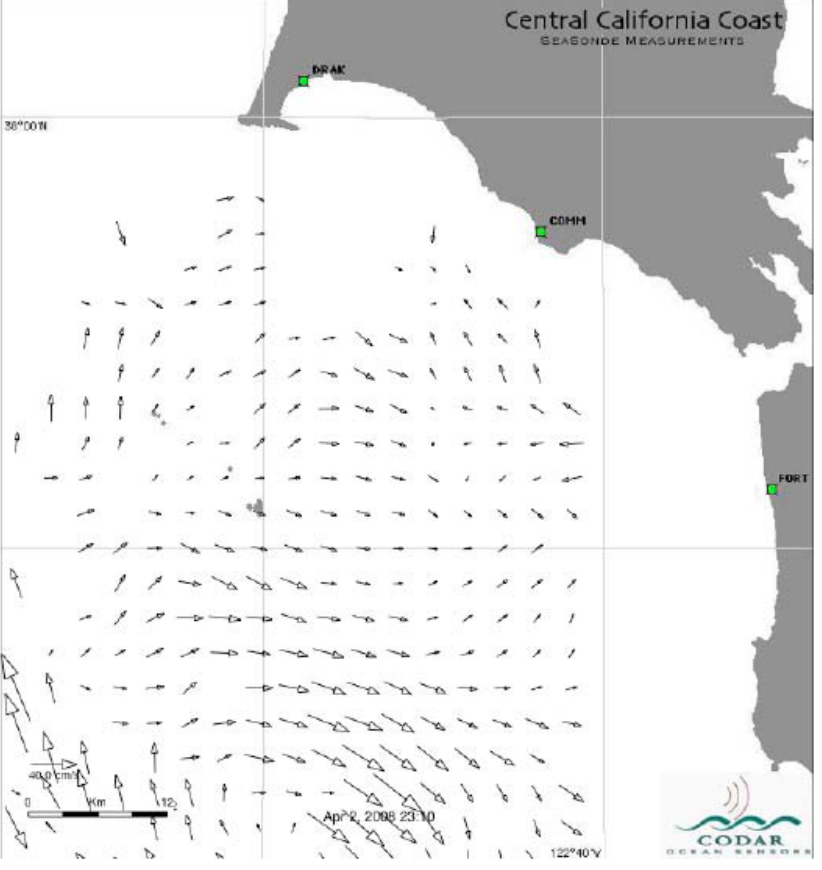
Figure 8. Radar total current velocity map produced from the radial velocities measured by the HF radars at COMM, FORT on April 02, 2008